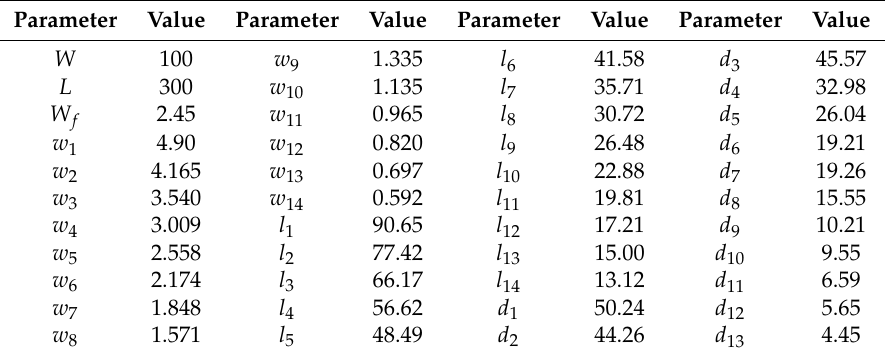
Figure 2. ( a ) Design concept of the meandered dipole element; ( b ) Simulated | S 11 | of the meandered dipole antenna and a straight dipole antenna. ( l MD = 90.65 mm and l SD = 115.50 mm). Table 1. Optimized Geometrical Parameters of the LPMDA Antenna (Units: millimeters).